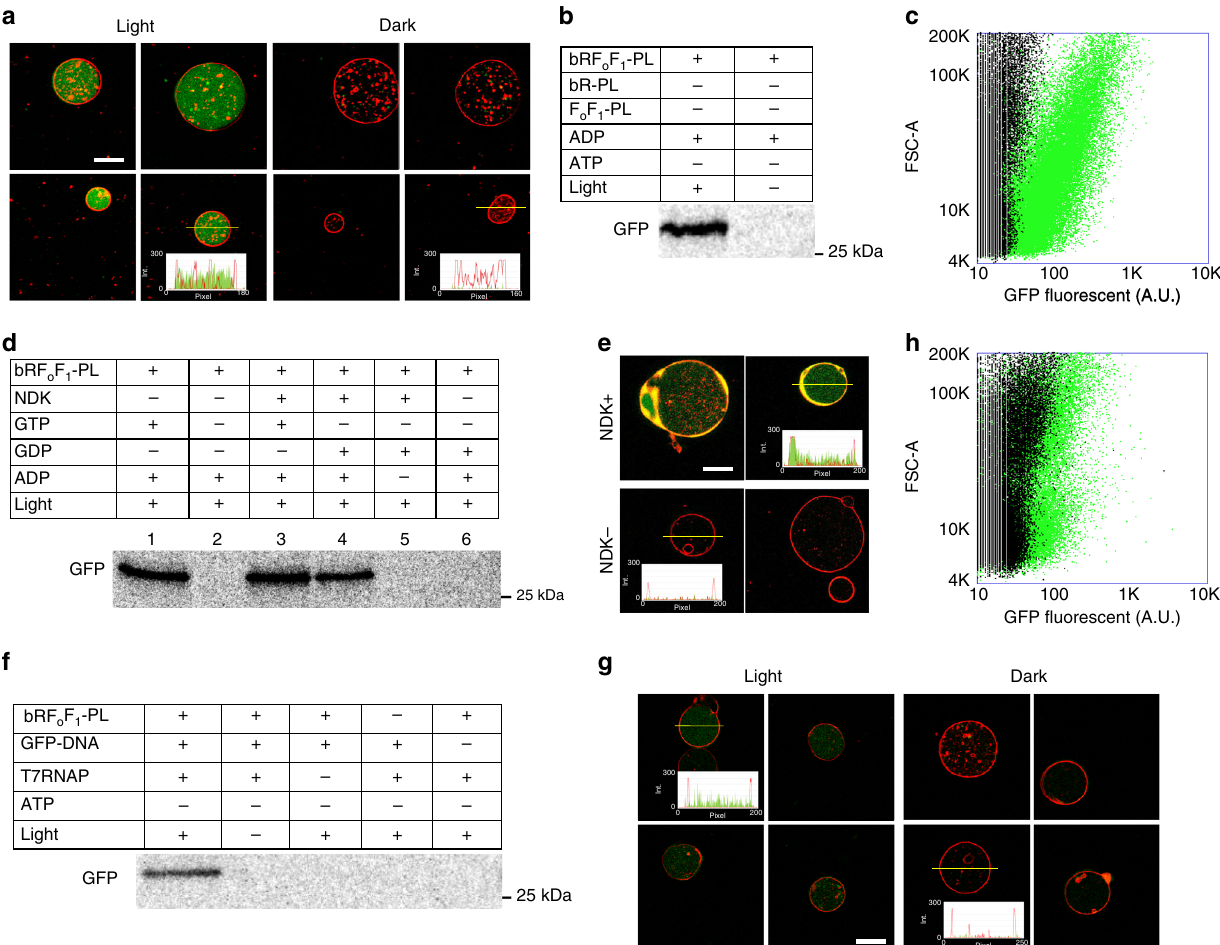
Fig. 2 Protein synthesis inside giant unilamellar vesicle (GUV) driven by light. Green fl uorescent protein (GFP) was synthesized from its messenger RNA (mRNA) ( a – e ) or DNA ( f – h ) inside light illuminated GUV ( a , c , e – h ) or in vitro ( b , d ). GFP was synthesized inside GUV ( a ) or in vitro (the PURE system) ( b ) in which the photosynthesized adenosine triphosphate (ATP) was consumed for the aminoacylation of transfer RNA (tRNA). The insets in a , e and g indicate plot pro fi le of green and red colors on the thin yellow line. c Flow-cytometric analysis of the GUVs of a . The illuminated GUVs are shown as green, whereas the GUVs incubated in the dark are shown as black. The X - and Y -axes represent the fl uorescent intensity and the area of forward scattering, respectively. d GFP synthesis coupled with guanosine 5 ’ -triphosphate (GTP) generation. GFP was synthesized in the PURE system with or without nucleoside-diphosphate kinase (NDK), GTP, guanosine diphosphate (GDP) and adenosine 5 ’ -diphosphate (ADP). e The same reactions as in lanes 4 and 6 of d were performed inside GUVs as indicated as NDK + and NDK − , respectively. f GFP synthesis from its DNA. A gene of whole GFP